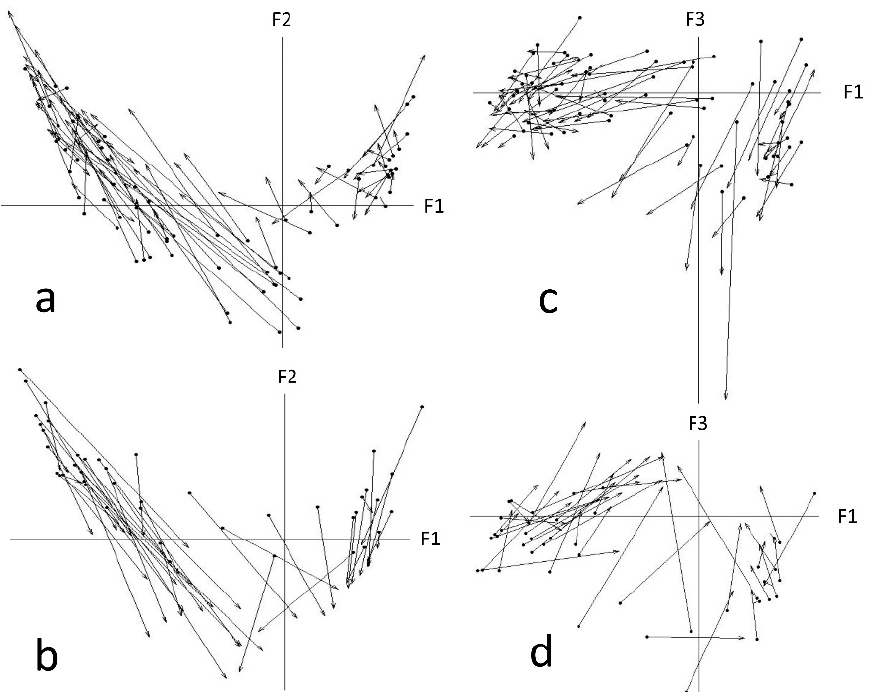
Figure 7. ( a ) Shifts of 71 sampling stations from their prefire positions (black dots) to their positions the first spring after a fire (arrowheads) on the first plane F1-F2 of the correspondence analysis of the bird matrix; ( b ) Shift of the stations from their positions the first spring after a fire (black dots) to their positions the eighth spring after a fire (arrowheads); ( c , d ) Idem on the plane defined by the first and third axes F1-F3 of the analysis. Repeated fires were not taken into account.